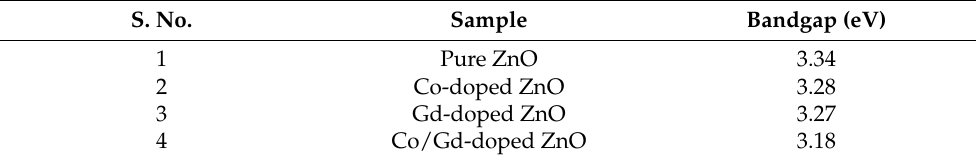
Figure 5. Tauc plot for ( a ) pure ZnO, ( b ) Co-added ZnO, ( c ) Gd-added ZnO, and ( d ) Co/Gd-added ZnO. Table 3. Optical bandgap of ZnO, Co-added, Gd-added, and Co/Gd ZnO nanoparticles. S.